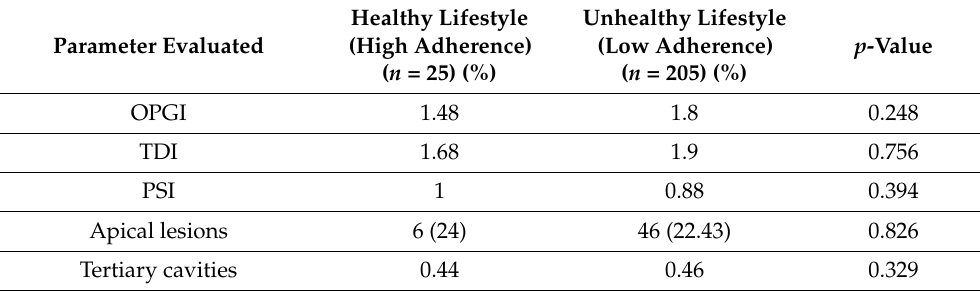
Table 5. Oral data and weekly activity.